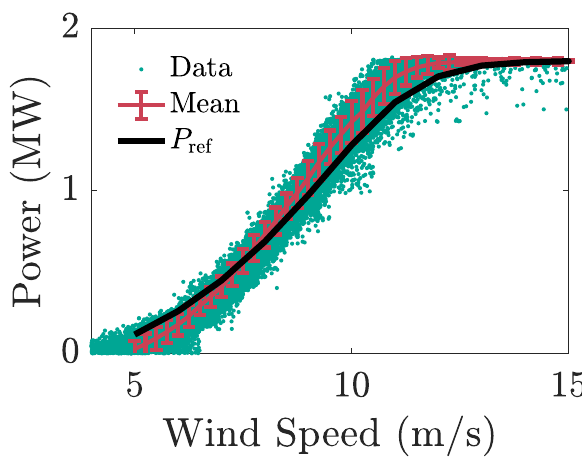
Figure 4. Power curve for a Vestas V80 turbine at the Summerview wind farm in Alberta, Canada for 250 ◦ inflow. The raw one-minute averaged data are shown with dots. Averaged data in 0.25 m/s bins are shown in red. The error bars represent one standard deviation in the data and are assumed to be symmetric about the mean. Horizontal error bars of ± 0.25 m/s are not included in the figure. P ref is a reference manufacturer power curve.